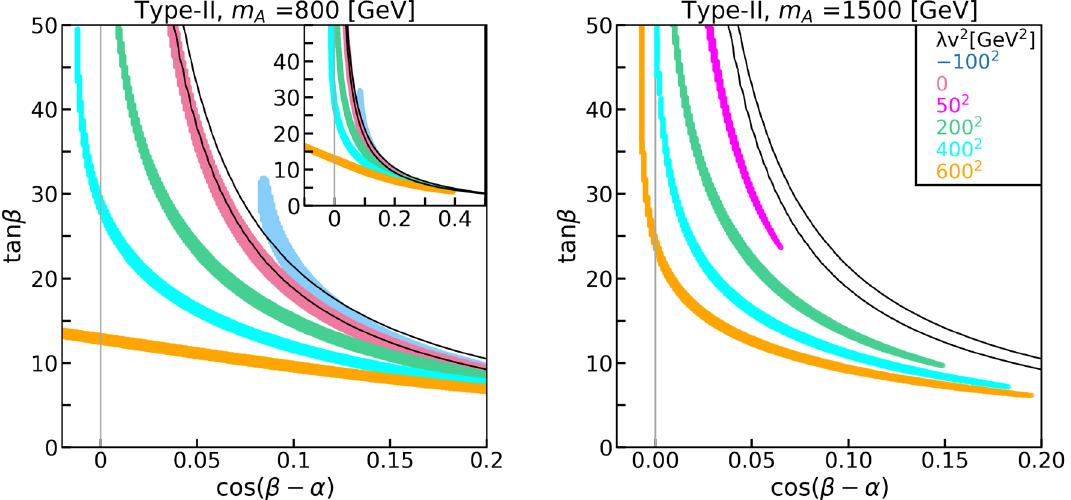
Fig. 5 The summarized allowed wrogn-sign Yukawa region in the plane of tan β - cos (β − α) at 95% C.L. for Type-II 2HDM, given LHC Run-II Higgs precision measurements at one-loop level. Here we take the benchmark parameters m A = m H = m H ± = 800 GeV (left) and 1500 GeV (right). The diffenet colorful regions are for λv 2 = − 100 2